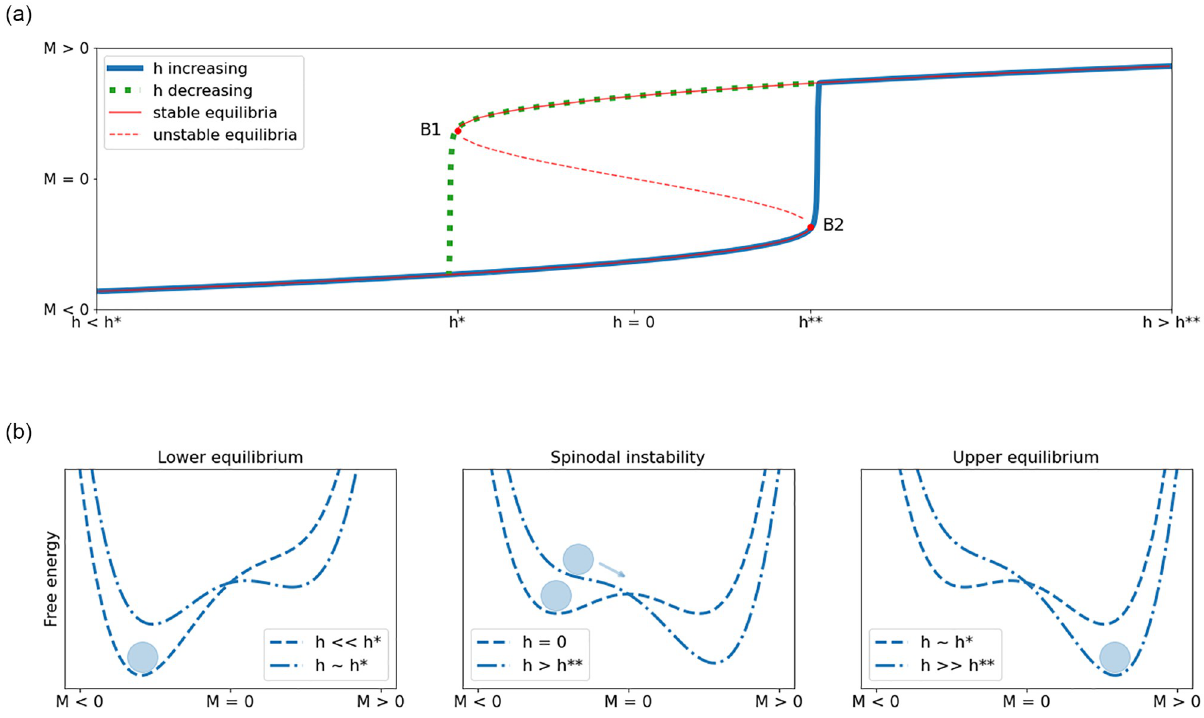
Fig 7. Critical transitions in the Ising model with temperature T fixed and an external magnetic field h slowly changing from negative to positive values. Top image: when increasing h , magnetization M jumps at h �� discontinuously from a lower to a higher equilibrium of spin states. When the process is reverted, with h decreasing, M jumps at h � back to the lower equilibrium, thus causing hysteresis (Tipping or bifurcation points indicated as B1 and B2). Bottom row plots show the CT in its Ginzburg-Landau form.